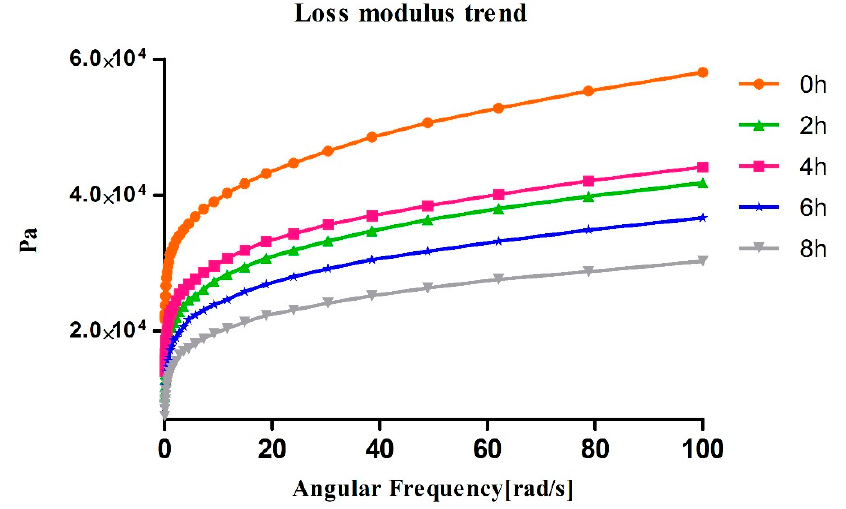
Figure 3. Loss modulus trends obtained through the rheology assay in fermented doughs.